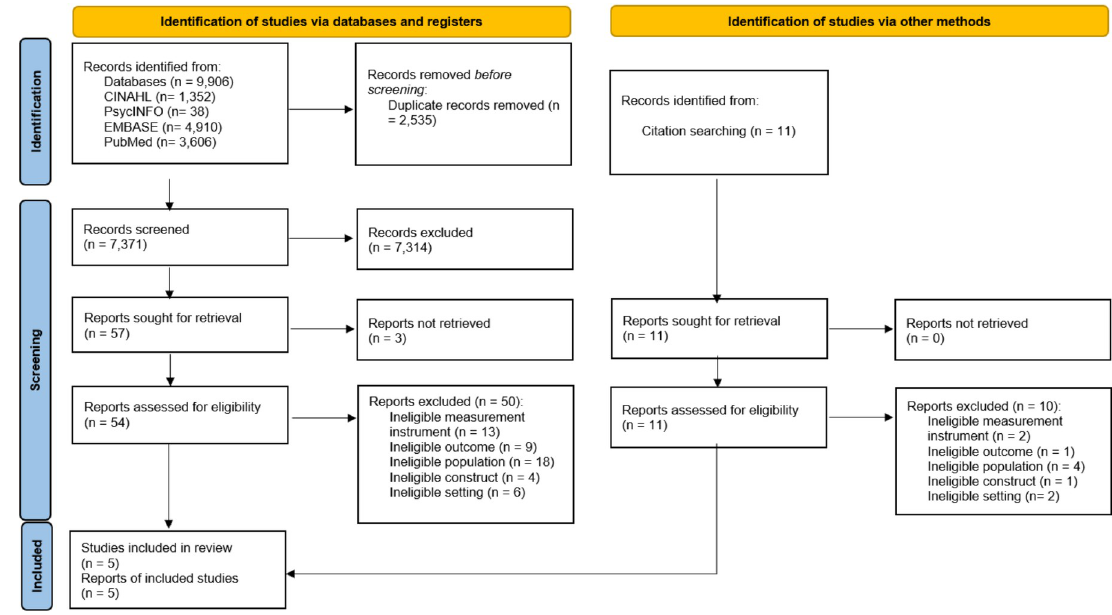
Fig 1. Process of identification, screening and exclusion of studies according to the PRISMA statement [29].